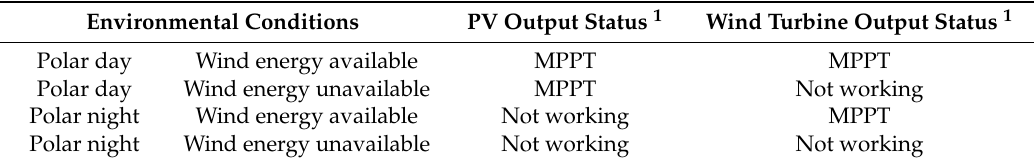
Table 5. The charging strategy of the hybrid wind-solar system ( T a > T c ).